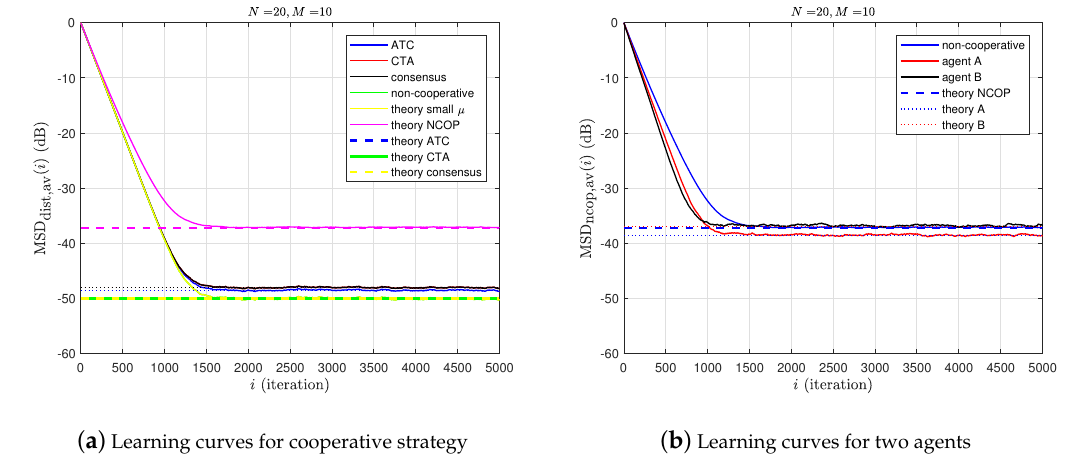
Figure 7. The learning curves for three cooperative strategies: ATC diffusion, CTA diffusion, and